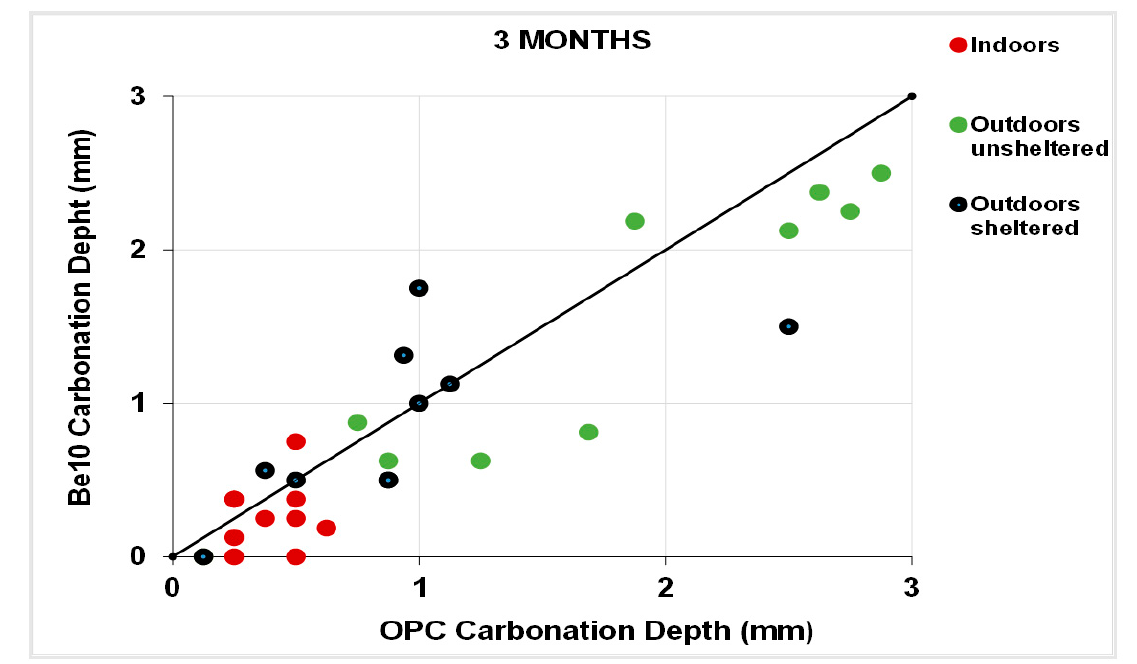
Figure 11. Three-month carbonation depth in reference OPC vs. 10% bentonite-bearing Be10.